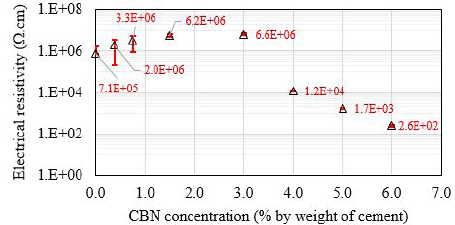
Figure 9. Electrical resistivity of mortars with different CBN contents at 28